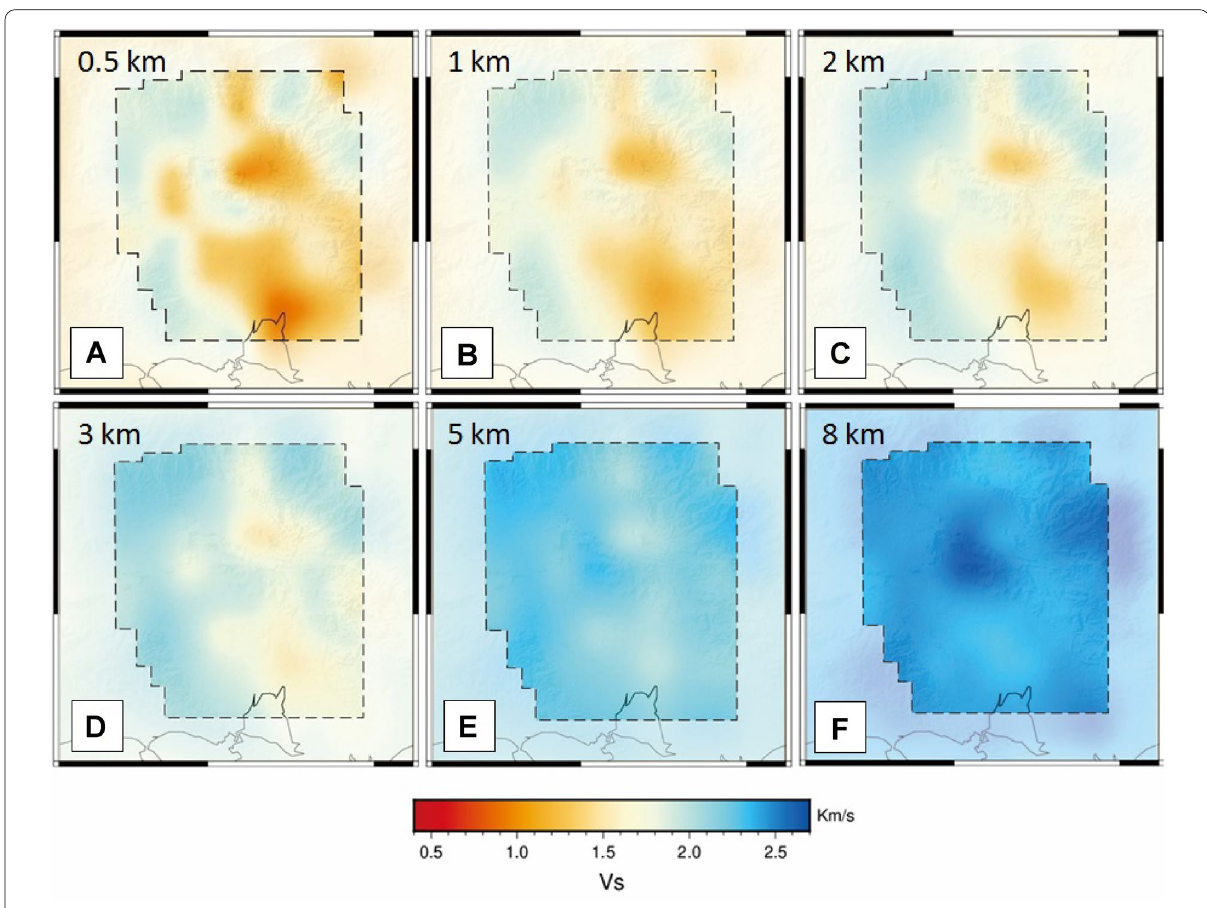
Fig. 6 Shear-wave velocity (Vs) maps at various depths, A 0.5 km, B 1 km, C 2 km, D 3 km, E 5 km, and F 8